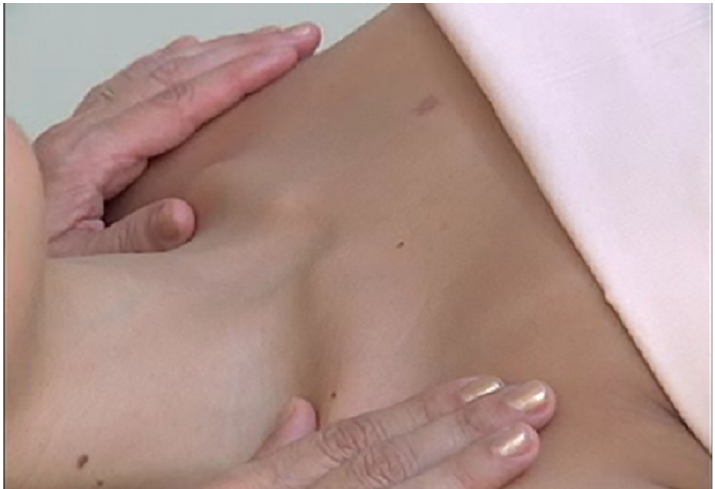
Figure 1C. Cervical lymphatic therapy